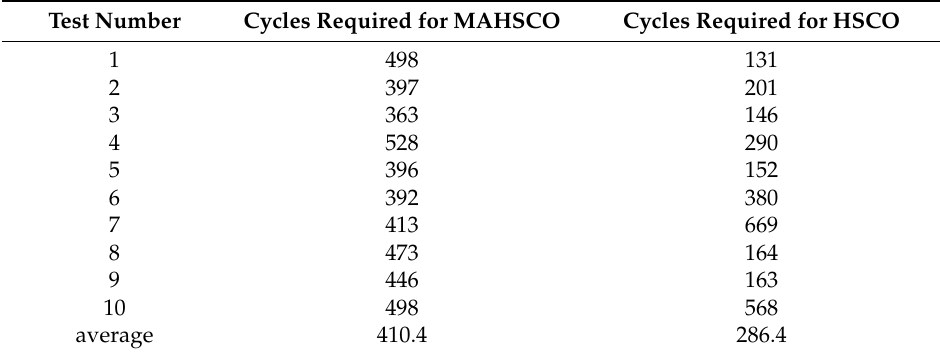
Table 5. Comparison of cycles required for the multi-agent hybrid social cognitive optimization (MAHSCO) and hybrid social cognitive optimization (HSCO)